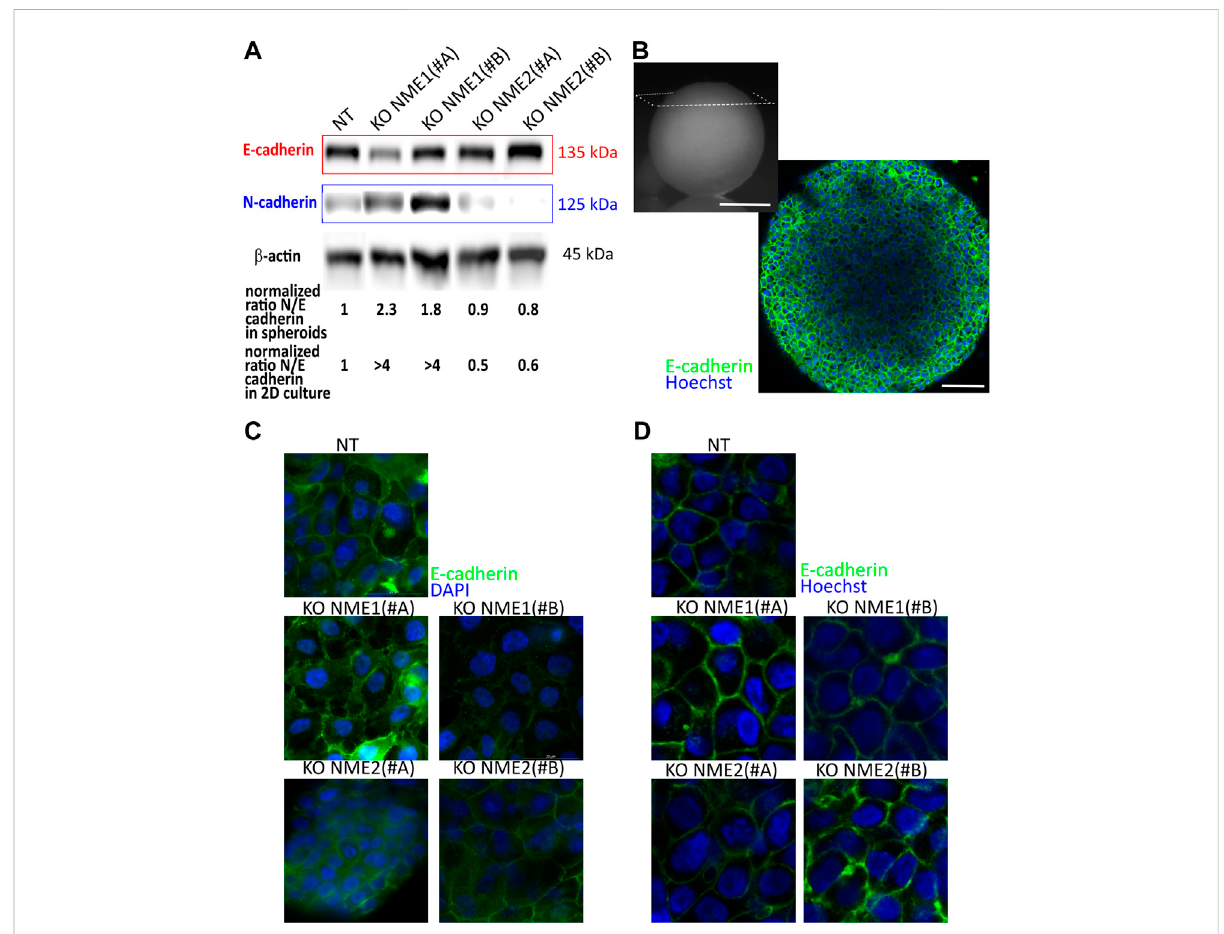
FIGURE 4 E-cadherinandN-cadherinexpressionaremodi fi edinspheroidsofNME1-ablatedcells. (A) WesternblotanalysisofE-cadherinandN-cadherin expression in NT-control cells compared to cells where NME1 or NME2 were inactivated. β -actin was used as a loading control. The ratio of N- to E-cadherin is calculated and renormalized to the ratio obtained for NT control cells. This ratio is explored in 3D spheroids and in 2D culture (data analyzed from Huna et al. (2021)). (B) Top left: image of a spheroid of 1 mm diameter of NT control cells. The observation plane is indicated in white(Scalebar:500 μ m).Bottomright:imageobtainedat70 μ mdepthpenetrationofE-cadherinlocalization.NucleiarestainedbyHoechst(Scale bar: 50 μ m). (C) Immuno fl uorescence confocal images of 2D culture cells from MCF10DCIS.com cells in which NME1 or NME2 was inactivated. E-cadherin antibody labeling is used. Nuclei are labeled with DAPI. The fi eld of view is a square of 50 μ m-long. (D) Immuno fl uorescence